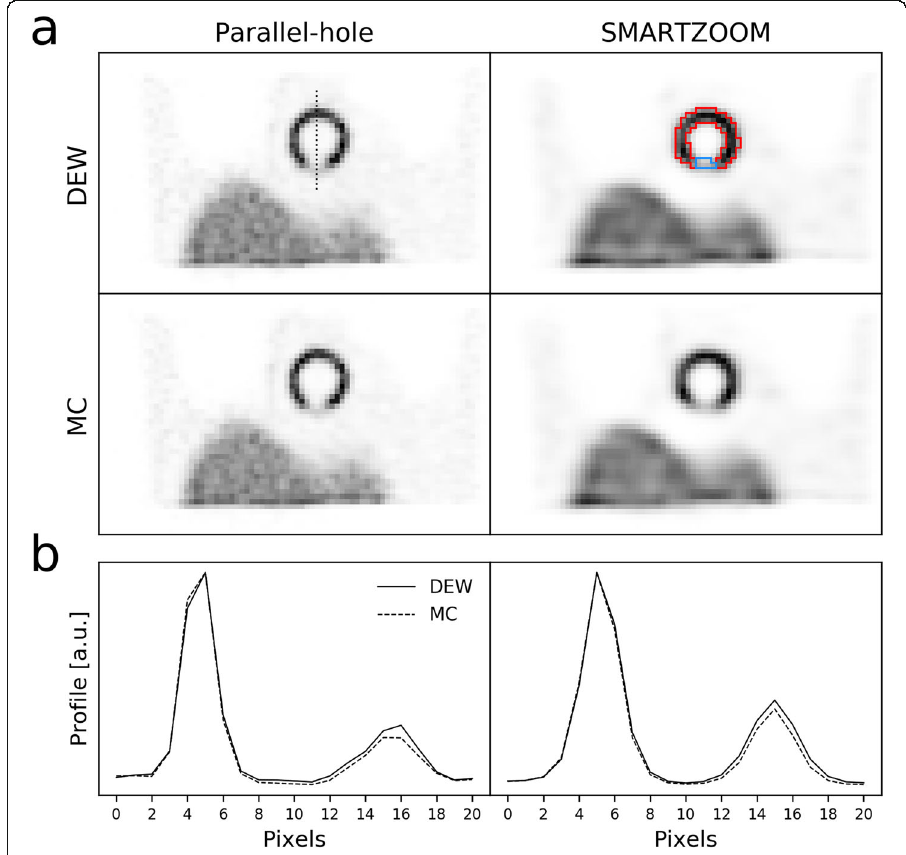
Fig. 6 a The reconstructions of the myocardial perfusion phantom at iteration 100 obtained with the parallel-hole and the SMARTZOOM collimator when reconstructed with dual-energy window and Monte Carlo-based scatter correction. The dotted line in the upper left reconstruction represents the location of the profiles. The red lines in the upper right reconstruction represent the mask of the hot wall and the blue lines represent the mask of the defect. b The profiles over the cardiac insert. The left and the right (lower) peaks are the hot wall and the defect,